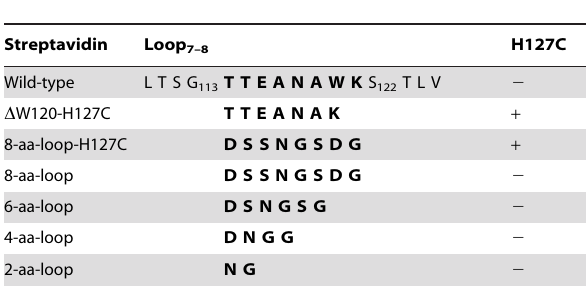
Table 1. Features of the loop 7–8